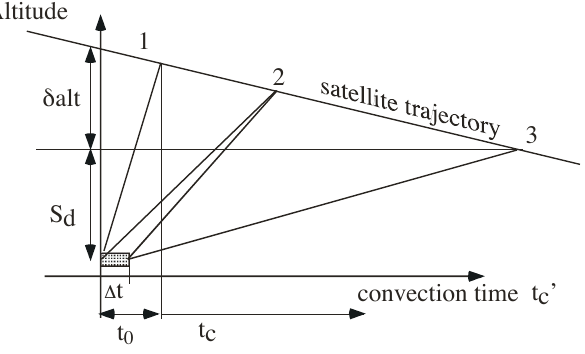
Fig. 1. Illustration of particle trajectories for particles with different velocities emanating from a finite low altitude source region. The x-axis shows the time the particle has been convecting away from the source, which for constant convection would be a distance scale. The point labeled 1 indicates the fastest particles which are thus ob- served furthest upstream. All trajectories between the two indicated trajectories reaching point 2 represent the velocities (i.e. different slopes) which can reach that observation point from a source of fi- nite extent (if particles with that velocity exist). At point 3 the extent of the source region is less significant and the range of observable velocities small.